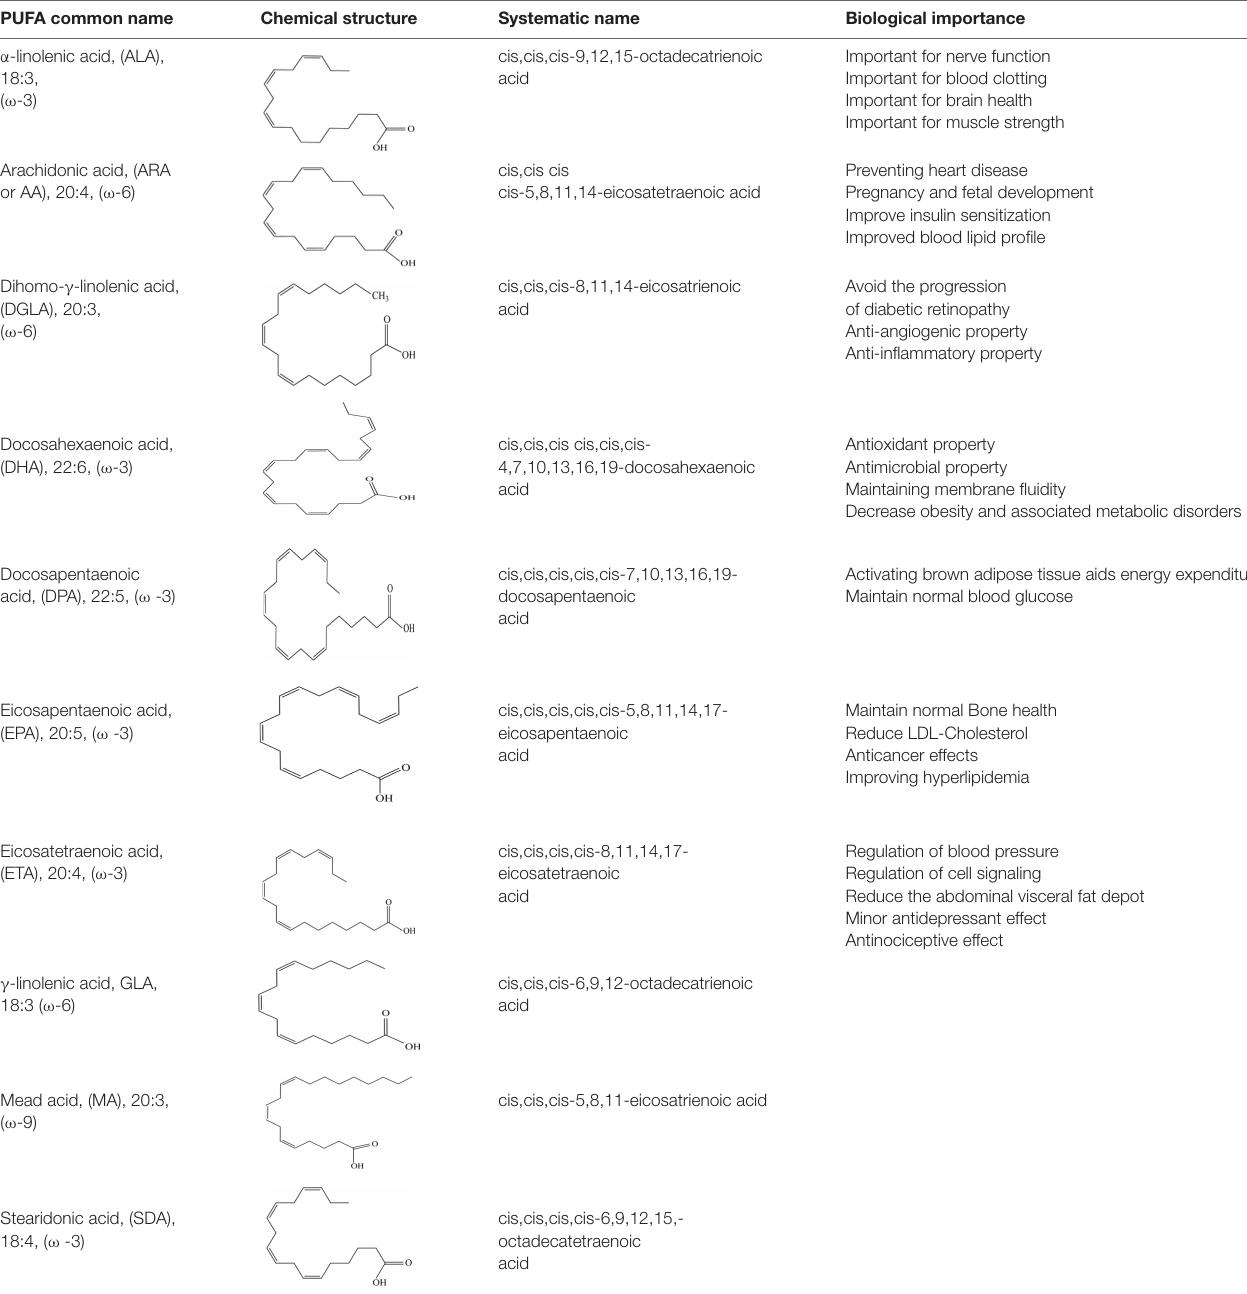
TABLE 1 | Details of some important PUFAs with general biological